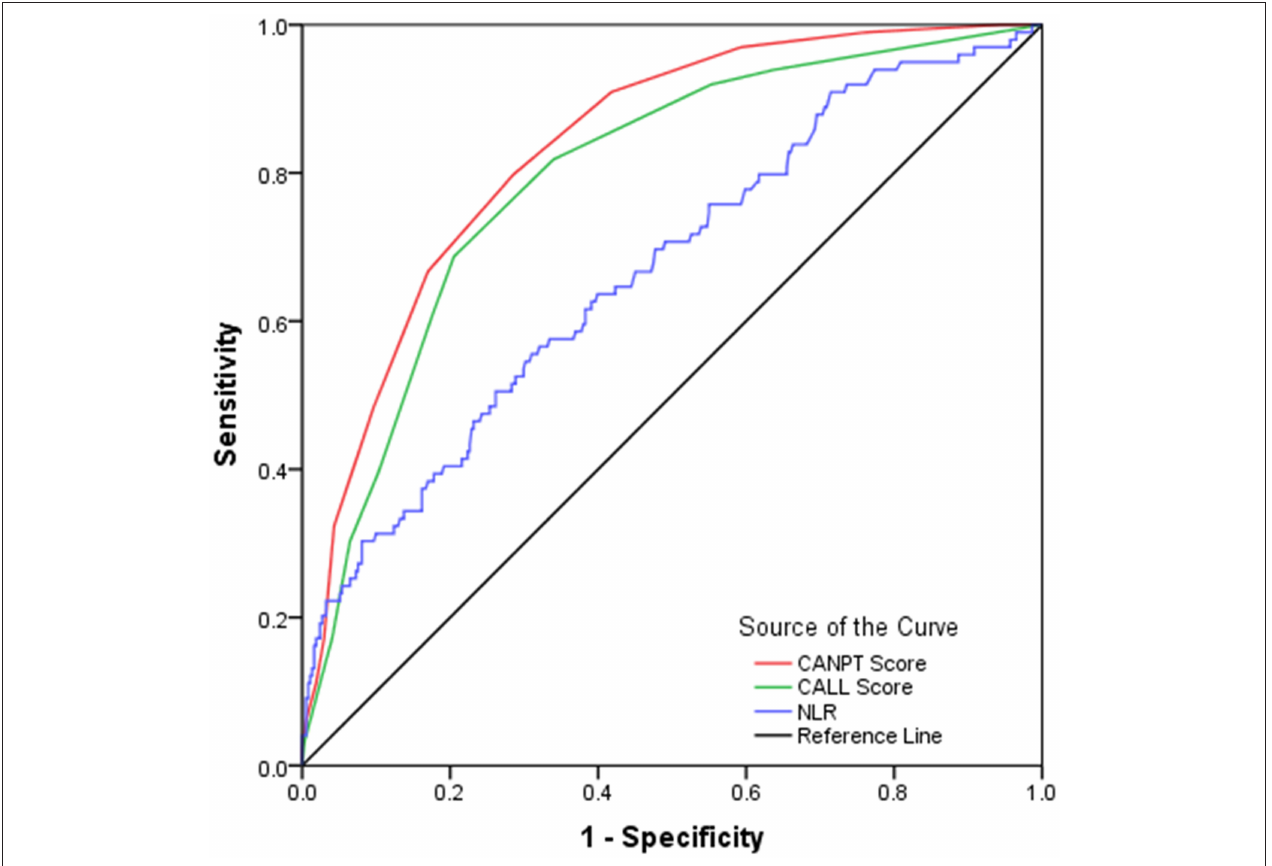
FIGURE 3 | ROC curves of the CANPT score, CALL score, and the NLR. The area under the receiver operating characteristic curves of the CANPT score, CALL score, and the NLR were 0.835 (95% CI, 0.794, 0.876), 0.795 (95% CI, 0.747, 0.844), and 0.669 (95% CI, 0.607, 0.730), respectively. ROC, receiver operating characteristic curve; CI, confidence interval; NLR, neutrophil-to-lymphocyte